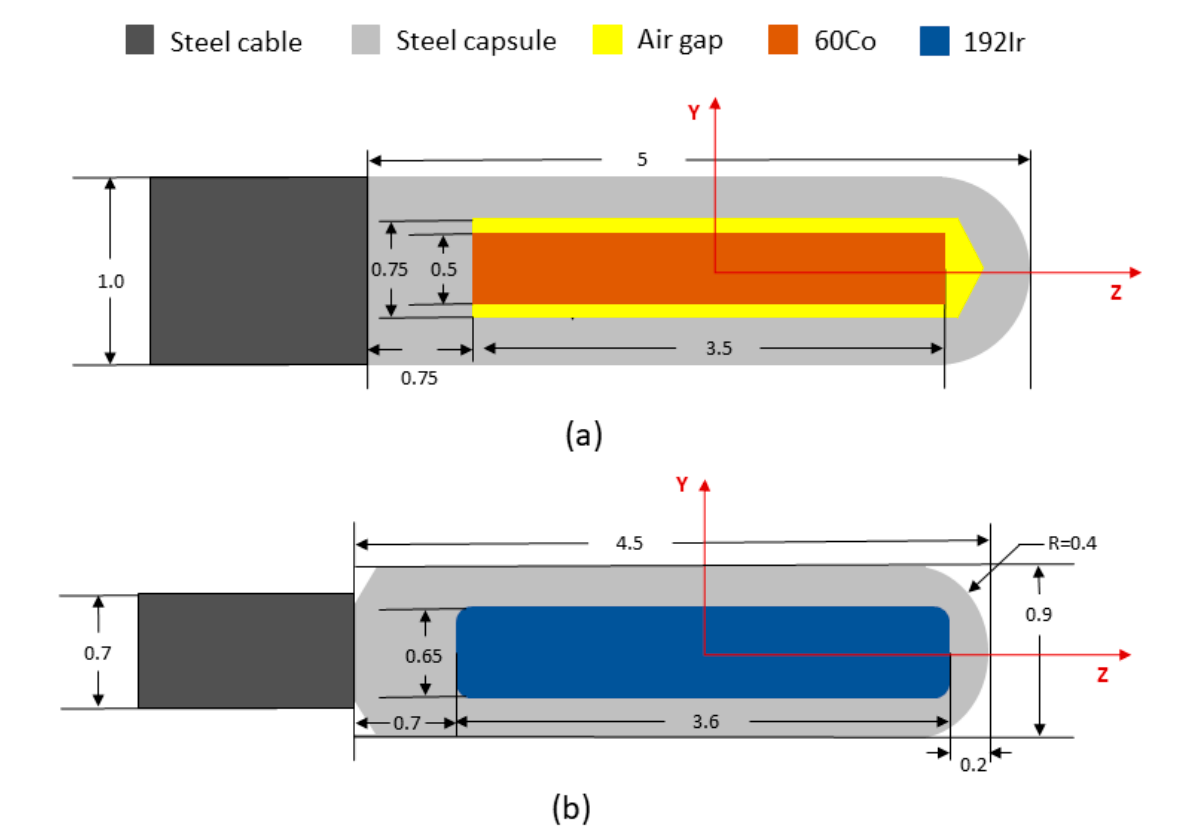
Figure 1. Reference coordinate system and schematic diagram of the model for 60Co and 192Ir. Dimensions are in millimeters. ( a ) E&Z Bebig HDR 60Co model Co0.A86 source; ( b ) Nucletron HDR 192Ir model mHDR-v2r.